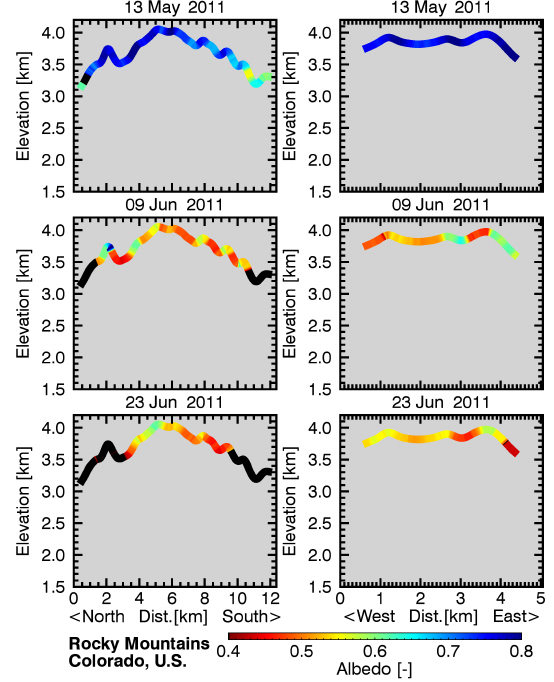
Figure 11. Same as Fig. 10 but for the Rocky